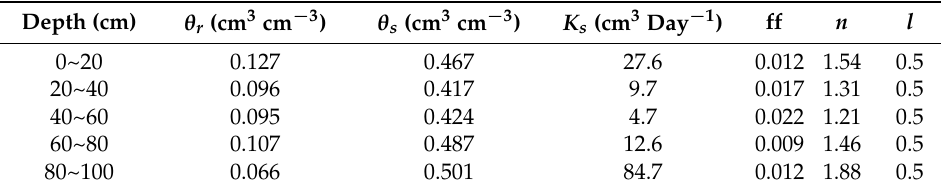
Table 4. Soil hydraulic parameters of the van Genuchten–Mualem model at the experimental site. Saturated water content ( θ s ) and saturated hydraulic conductivity ( K s ) were measured values, whereas θ r , α and n were estimated through inverse simulation. Depth